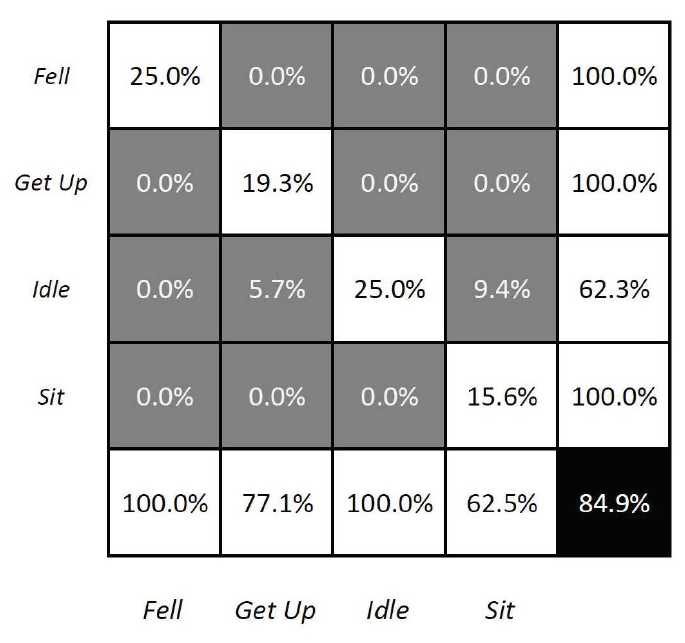
Figure 5. The confusion matrix of the LSTM